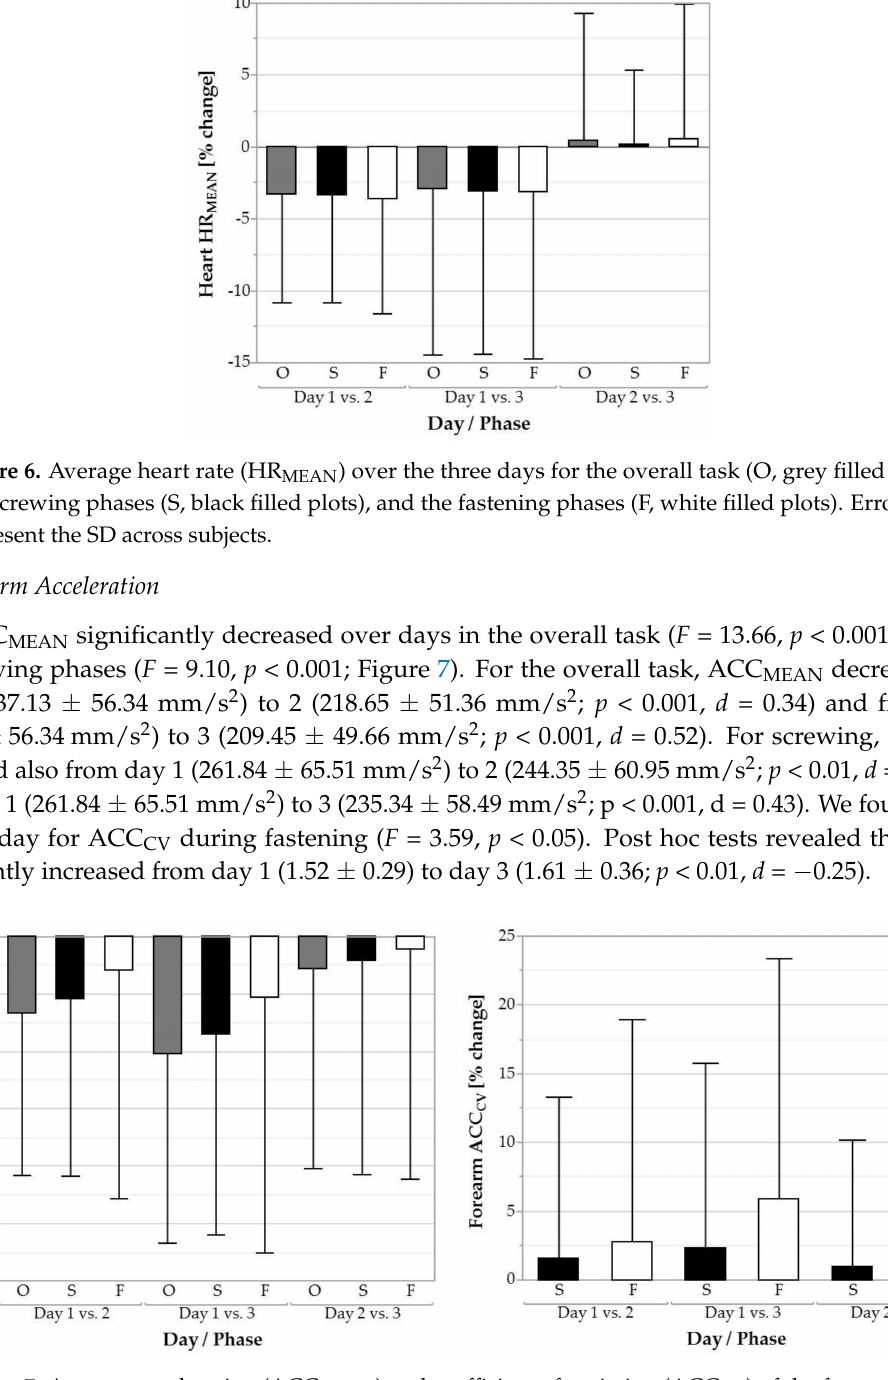
Figure 7. Average acceleration (ACC MEAN ) and coefficient of variation (ACC CV ) of the forearm over three days for the overall task (O, grey filled plots), the screwing phases (S, black filled plots), and the fastening phases (F, white filled plots). Error bars represent the SD across